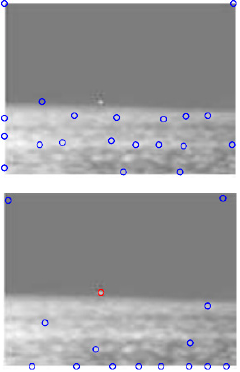
Table 5. Average running time (s) of different methods.